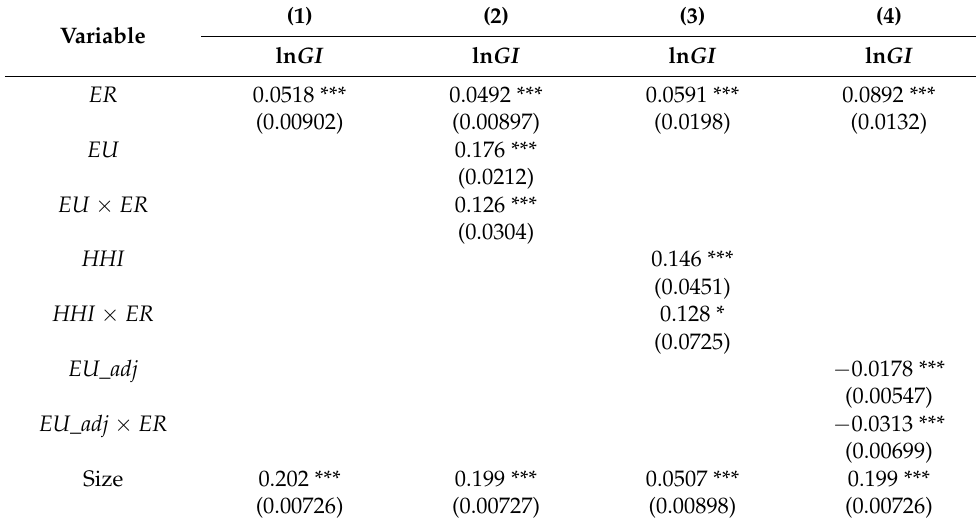
Table 8. Regression Analysis of Environmental Uncertainty, Environmental Regulation and Enter- prises’ Green Technological